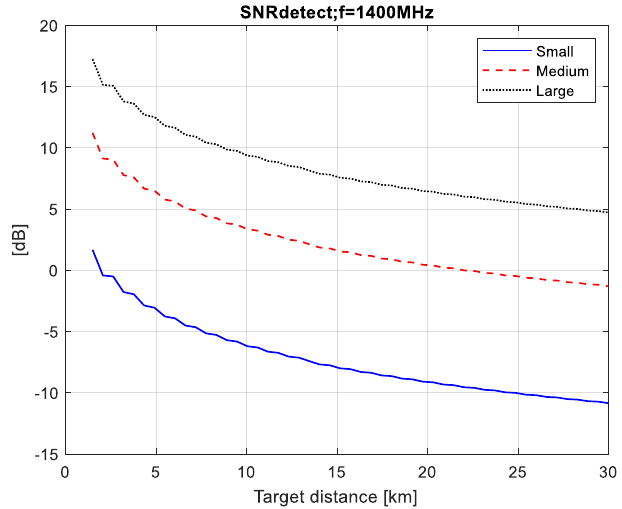
Figure 4. 𝑆𝑁𝑅 𝑑𝑒𝑡 values for pulsar FSR.